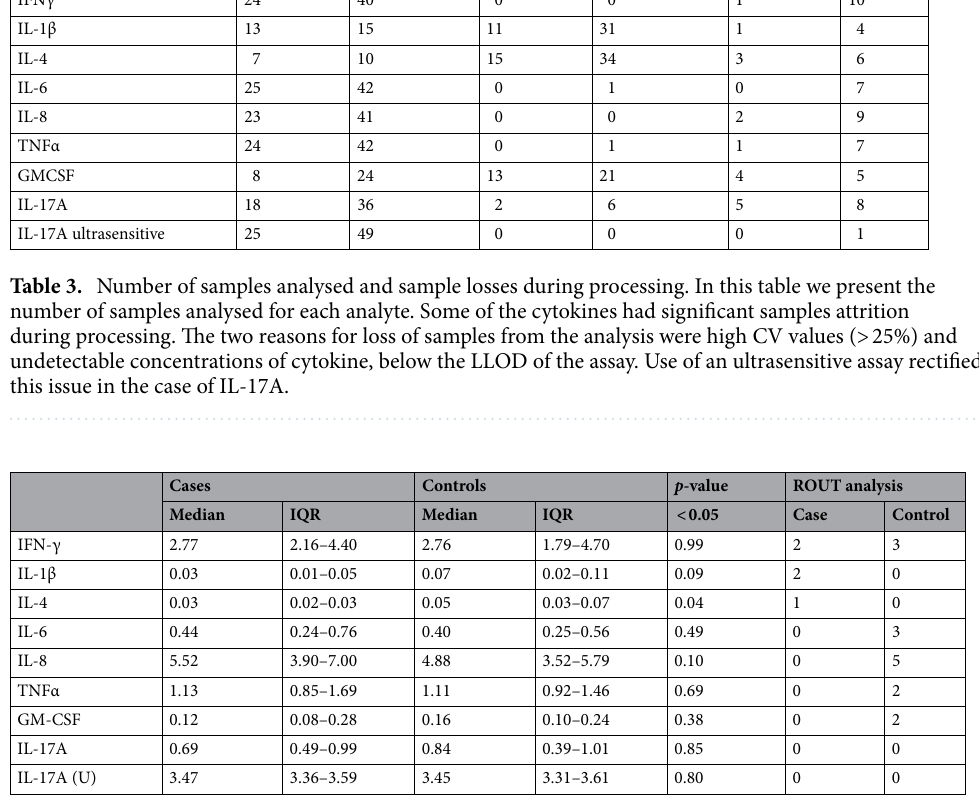
Table 4. Summary table of cytokine analysis results. In this table we quote all analyte concentrations in pg/ mL except for ultrasensitive IL-17A assay (IL-17A (U)) which we quote in fg/mL. p -values are statistically significant at values less than 0.05. Outliers were removed using ROUT analysis on GraphPad Prism 7 (GraphPad Software Inc., San Diego, CA). The final column “ROUT analysis” indicates the number of outliers removed from each group per analyte. We used Mann Whitney U-tests for the calculation of p-values as data were non-parametric.